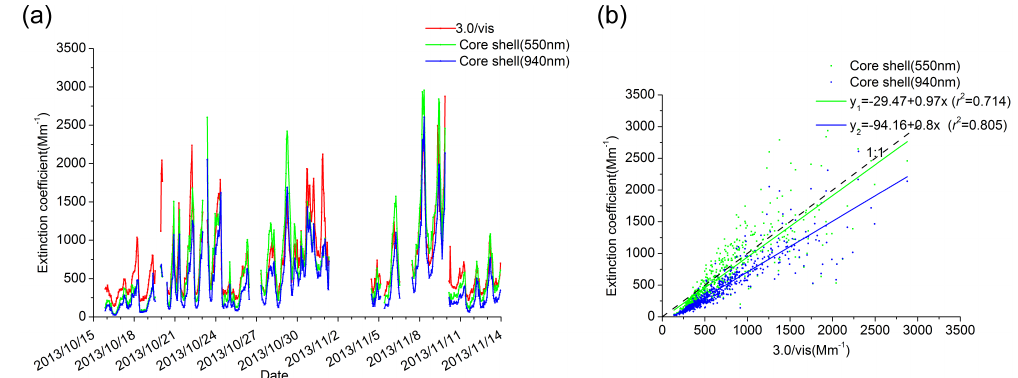
Figure 6. Relationships among the calculated and measured values based on the core-shell model ( λ = 550nm, 940nm).